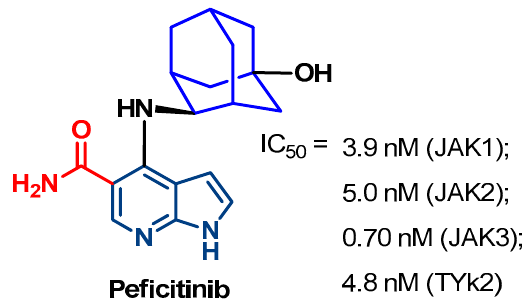
Figure 44. Kinase inhibitory activities of